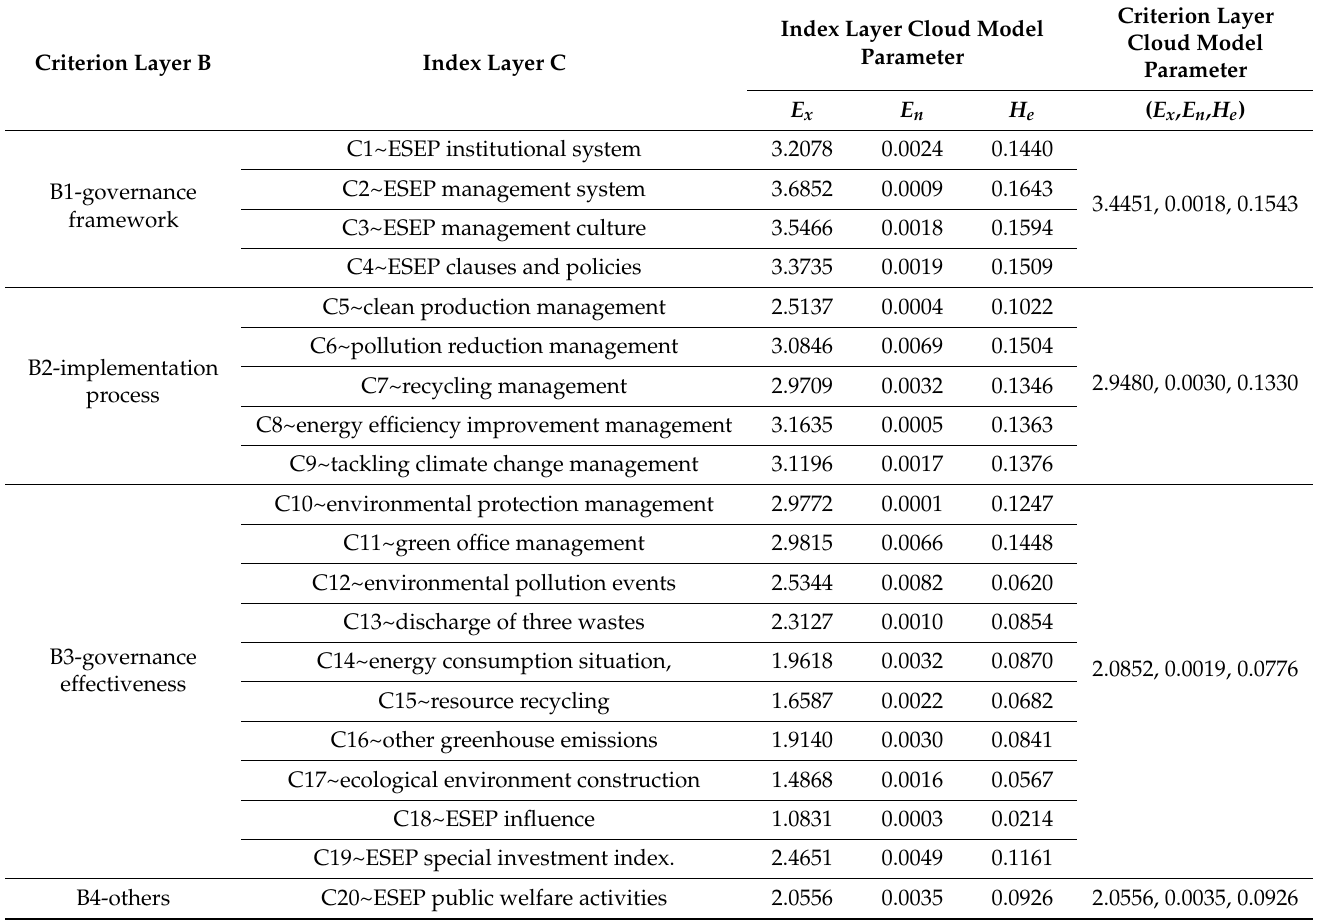
Table 5. Characteristic values of cloud